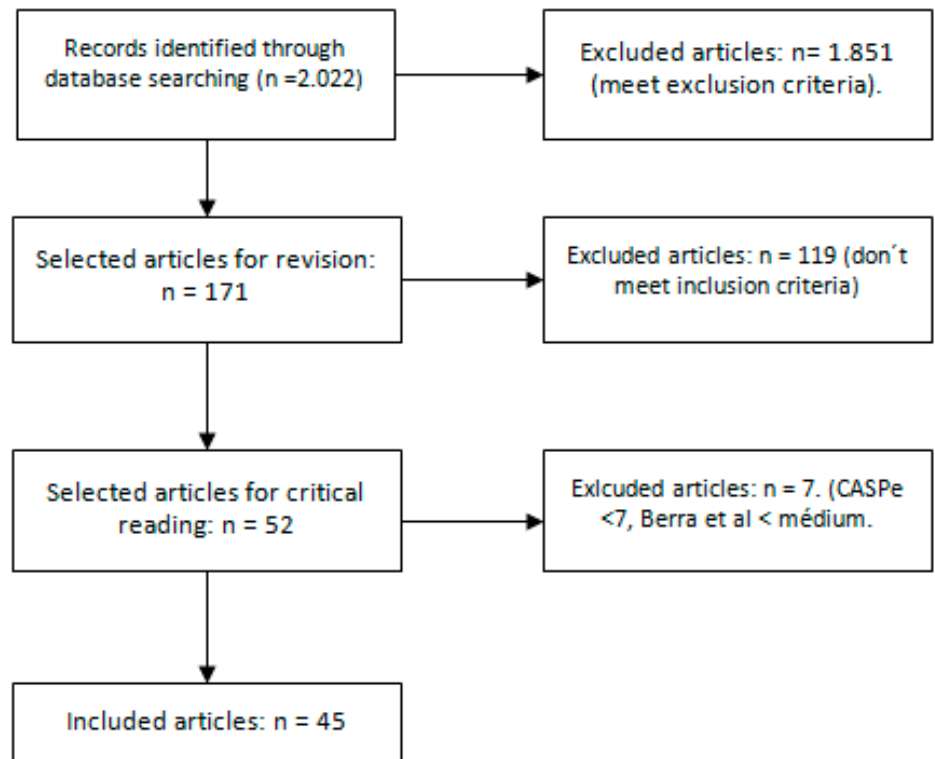
Figure 1. Search strategy flowchart.